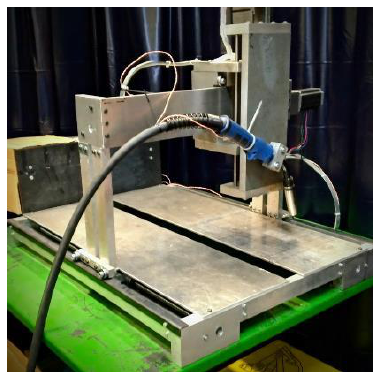
Figure 3. CNC equipment with an adaptation for a welding torch.